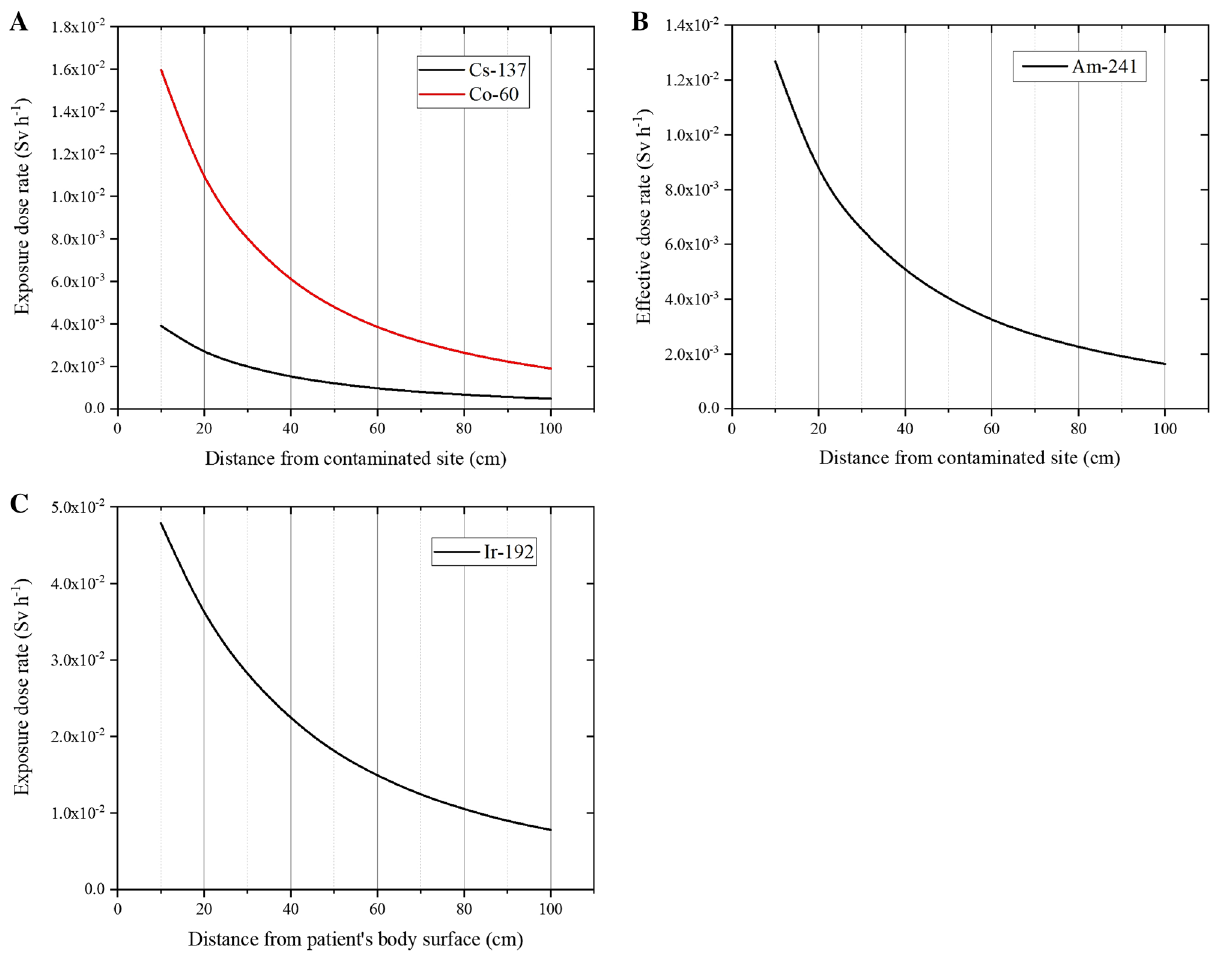
Figure 4. Exposure doses of an emergency medical responder who cares for a patient with highly radioactive contamination during a radiological accident. Table 1 shows the detailed assumptions for these scenarios (Scenario 2). ( A ) Radiological accidents associated with the theft of medical/industrial radiation sources, assuming a 10-GBq source. ( B ) Radiological accidents caused by mishandling of industrial radiation source, assuming a 185-GBq source. ( C ) Radiological accidents related to mishandling of a medical radiation source (e.g., for brachytherapy), assuming a 137-GBq source. Expected time to reach dose Radionuclides